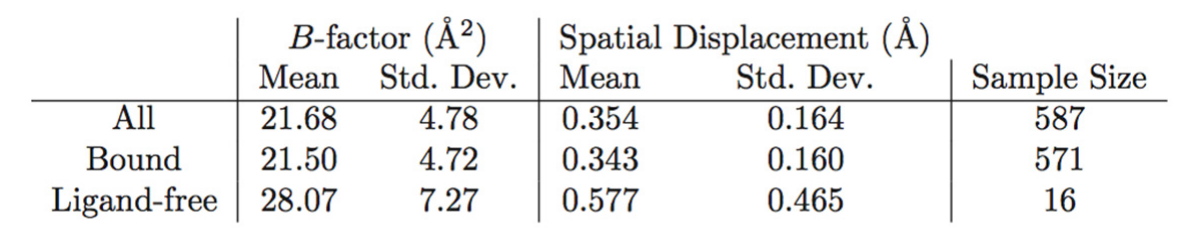
Table 2. PR B-factor and spatial displacement distribution. This table shows the mean spatial displacement observed in the ligand-bound Vs ligand-free PR structures. This table is a figure.